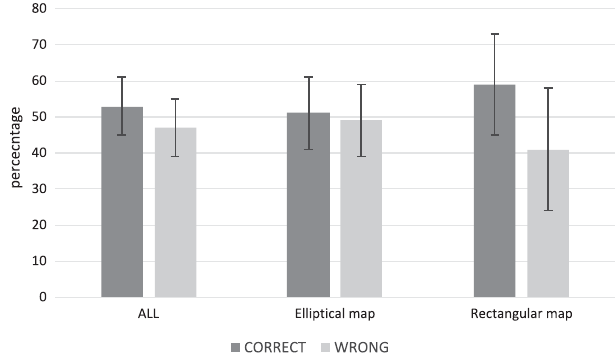
FIG. 10. Students ’ responses to the question of the curvature of space were examined to determine if they were influenced by an elliptical ( N ¼ 53 ) or rectangular ( N ¼ 22 ) map of the CMB on a postinstruction exam.